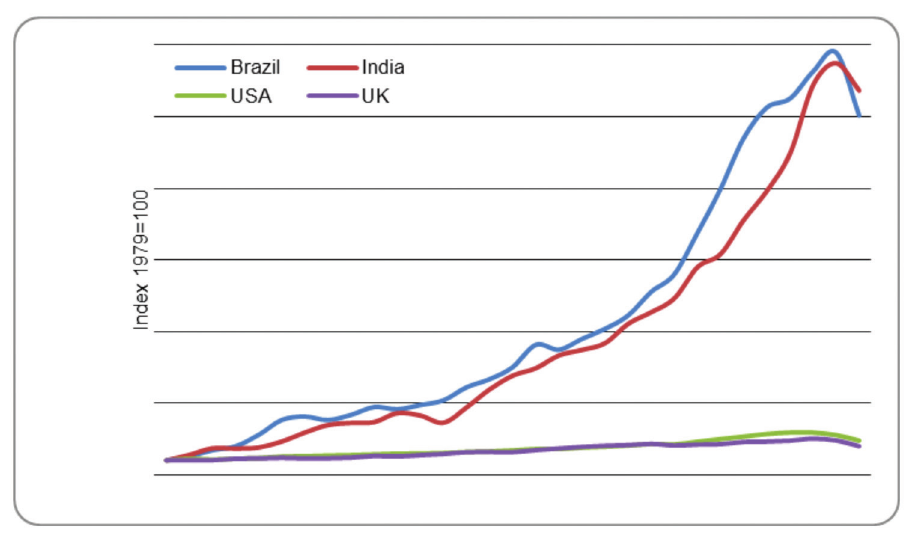
Figure 3: Relationship between GDP and TEU growth for developing and developed countries (GDP data from IndexMundi, 2011; TEU data from Sooredoo,